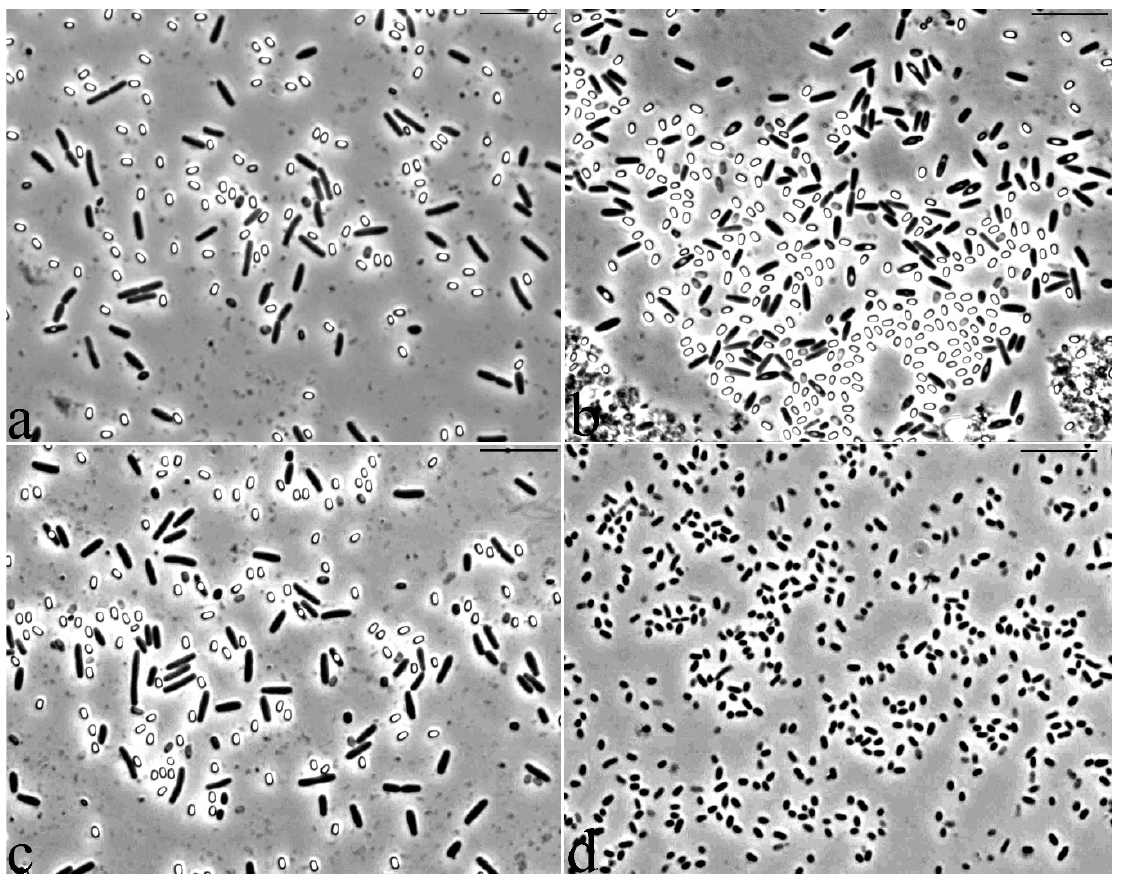
Figure 1. Cells of the studied strains in the exponential growth phase. ( a ) B. subtilis 27; ( b ) B. subtilis 28; ( c ) B. subtilis 18; ( d ) P. chlororaphis 3. Light microscopy. Phase contrast. Bar—10